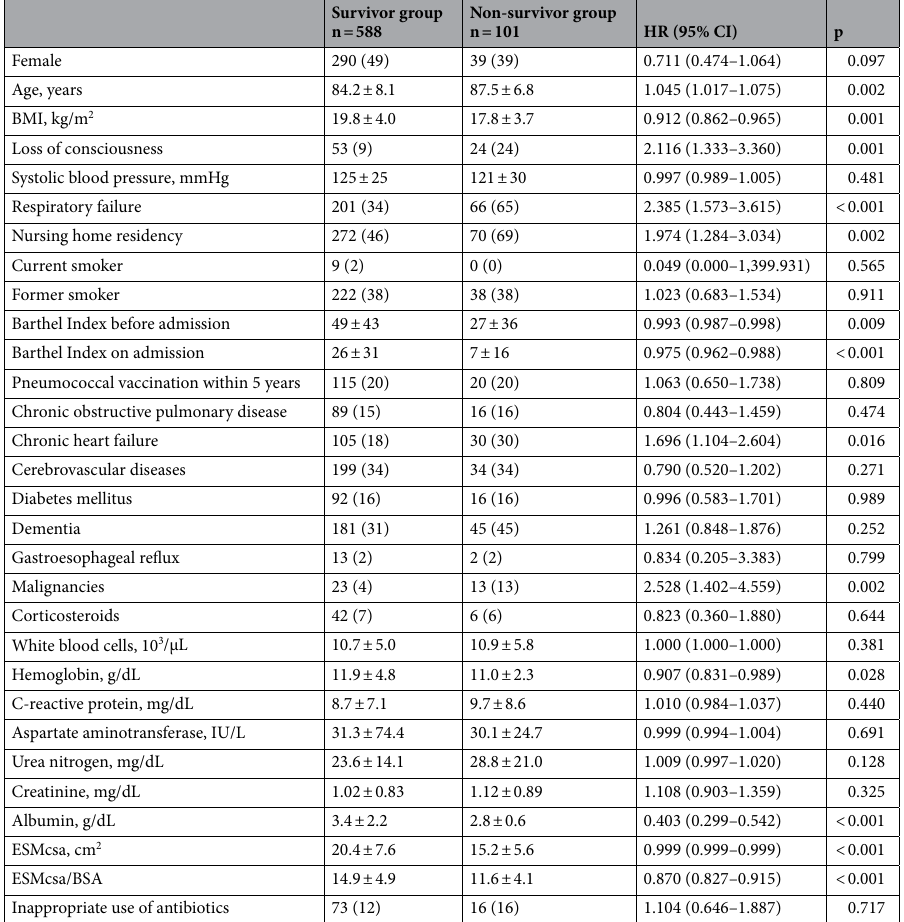
Table 2. Univariate Cox proportional hazards analyses of all-cause in-hospital mortality. Data are presented as the number (%) or mean ± SD. BMI body mass index, BSA body surface area, CI confidence interval, ESM erector spinae muscle, ESMcsa cross-sectional area of ESM, HR hazard ratio, SD standard deviation.